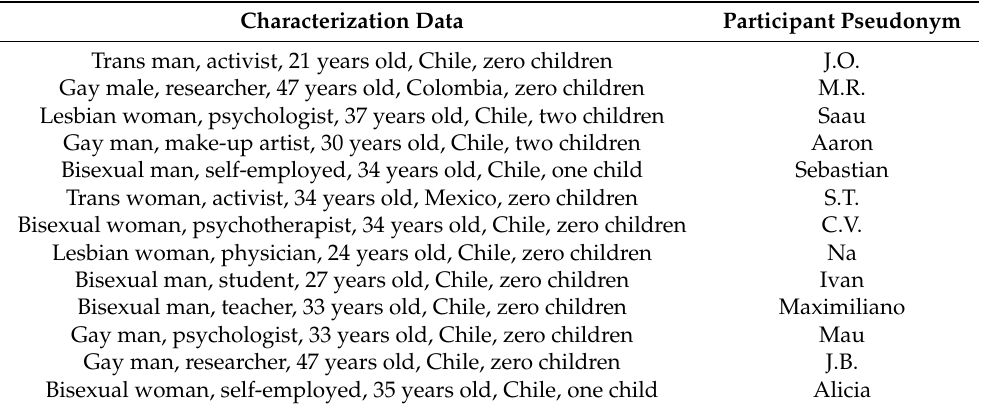
Table 1. Coding of participants. Characterization